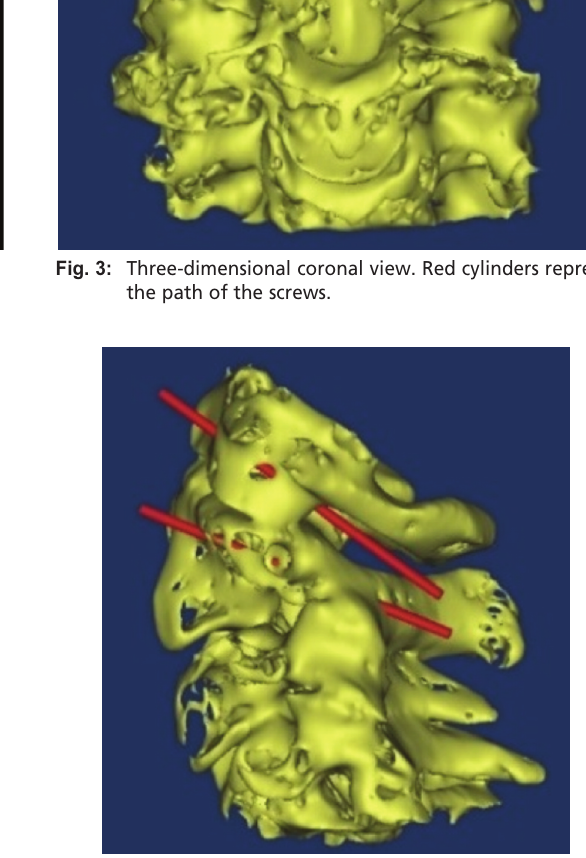
Three-dimensional axial view. Red cylinders represent Fig. 5: the path of the